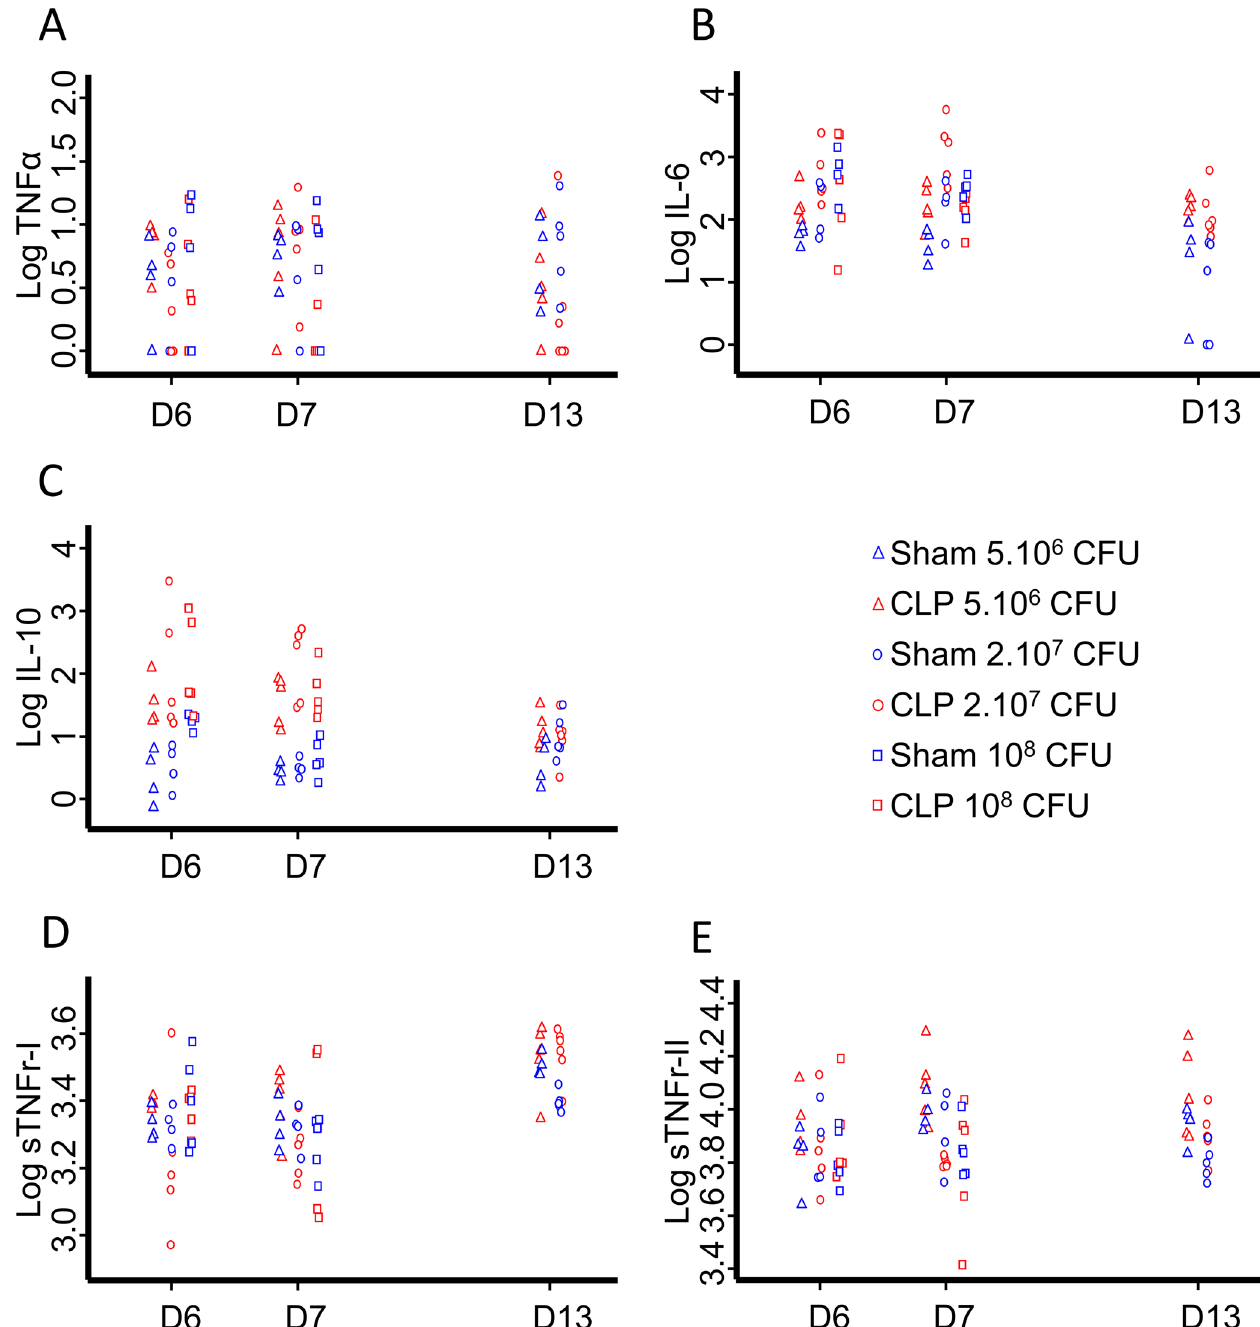
Fig 6. Plasmatic cytokines assessment after bacterial challenges. Plasma was collected 1 (D6), 2 (D7) and 8 (D13) days after P . aeruginosa intratracheal instillation and TNF α , IL-6, sTNFr I and II and IL-10 were measured thanks to the Luminex technique (n (cid:3) 4 for each groupe or dose). While no group, nor time or dose effect could be evidenced for TNF α (A), IL-6 and IL-10 levels were dose-dependent and decreased over time (B and C). No group effect but a dose-dependent decrease of sTNFr-I (D) at D13 and sTNFr-II (E) at D6, D7 and D13 were observed. sTNFr-I increased over time whereas sTNFr-II did not. Results are expressed as Log(pg/ml). Effects are considered significant when p <